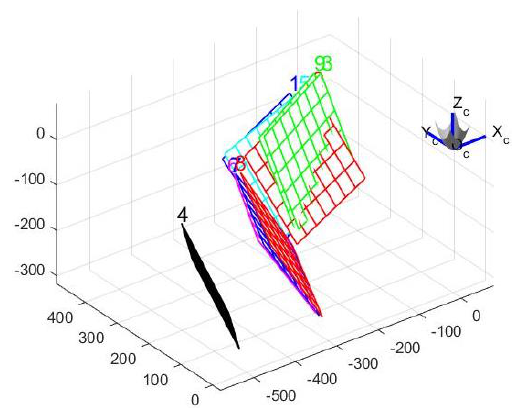
Figure 18. Show extrinsic.